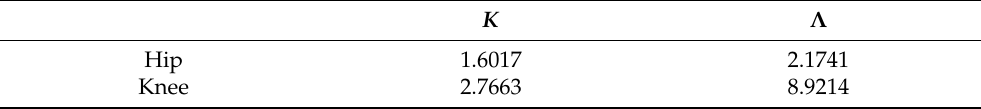
Table 3. Optimized gains by GA.